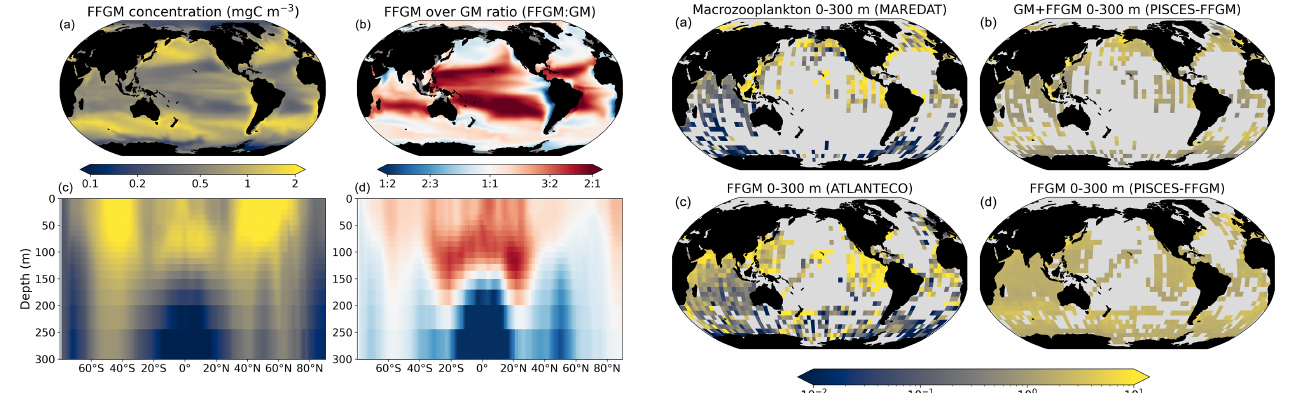
Figure 3. FFGM and FFGM:GM ratio. Annual mean of FFGM carbon concentrations (mgCm − 3 , log scale) averaged over the top 300m (a) and zonally averaged (c) . Annual of mean FFGM:GM ratio, averaged over the top 300m (b) and zonally averaged (d) . Red tones indicate FFGM dominance, and blue tones indicate GM dominance.